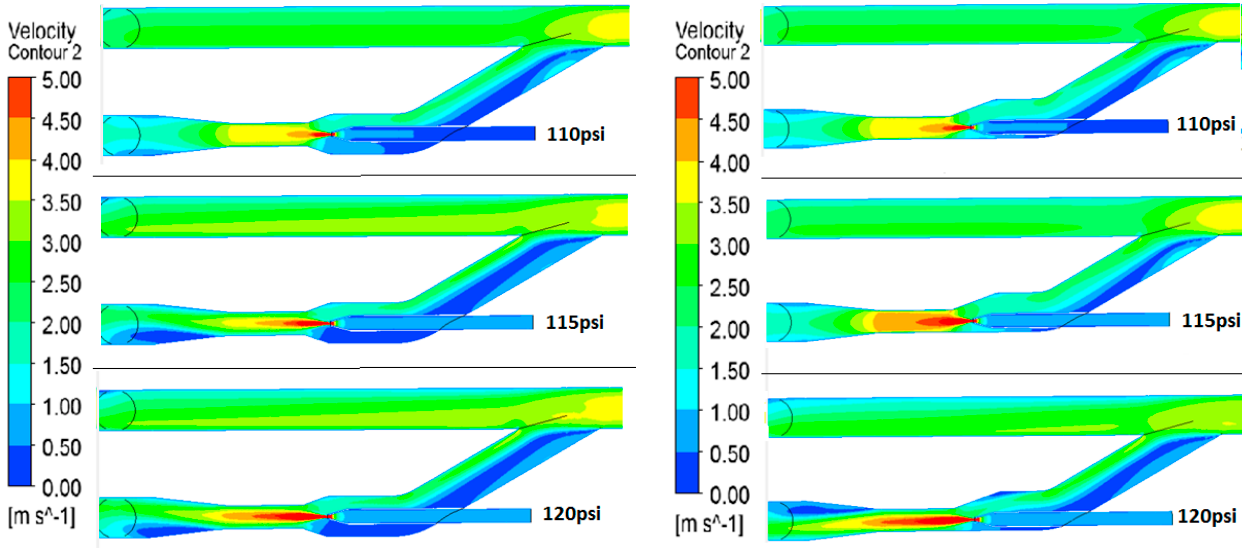
Figure 23. Velocity contours for concentric and eccentric pump. Single-phase simulation.